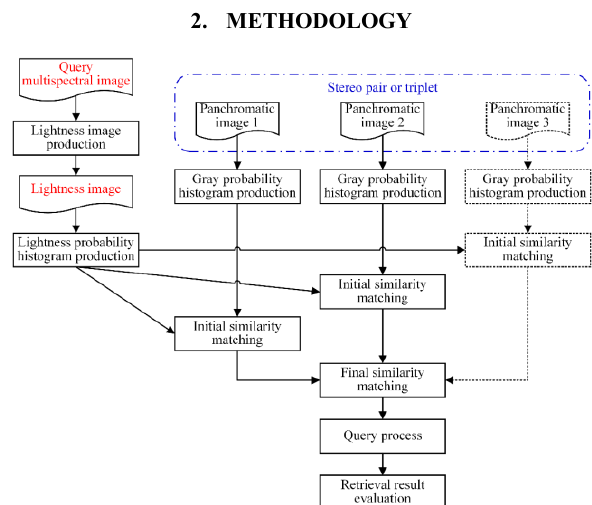
Figure 1. Flowchart of the proposed cross-sensor retrieval method for using a multispectral image to retrieve stereo